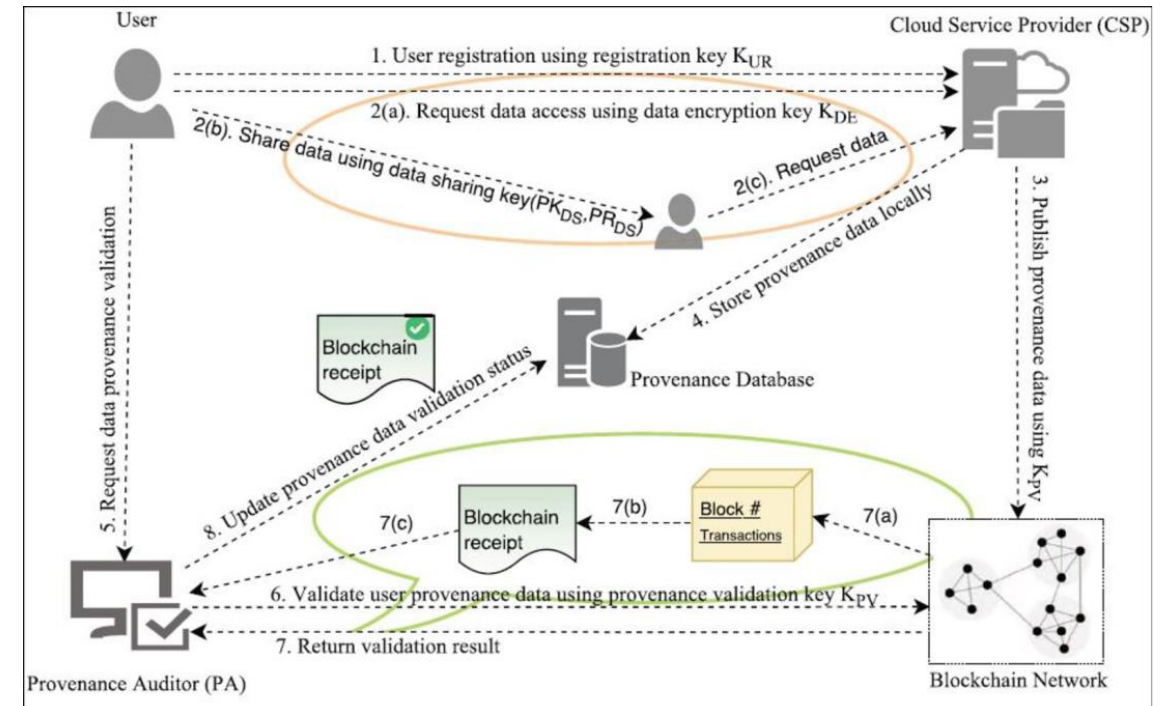
Figure 4. Interaction of the ProvChain System.